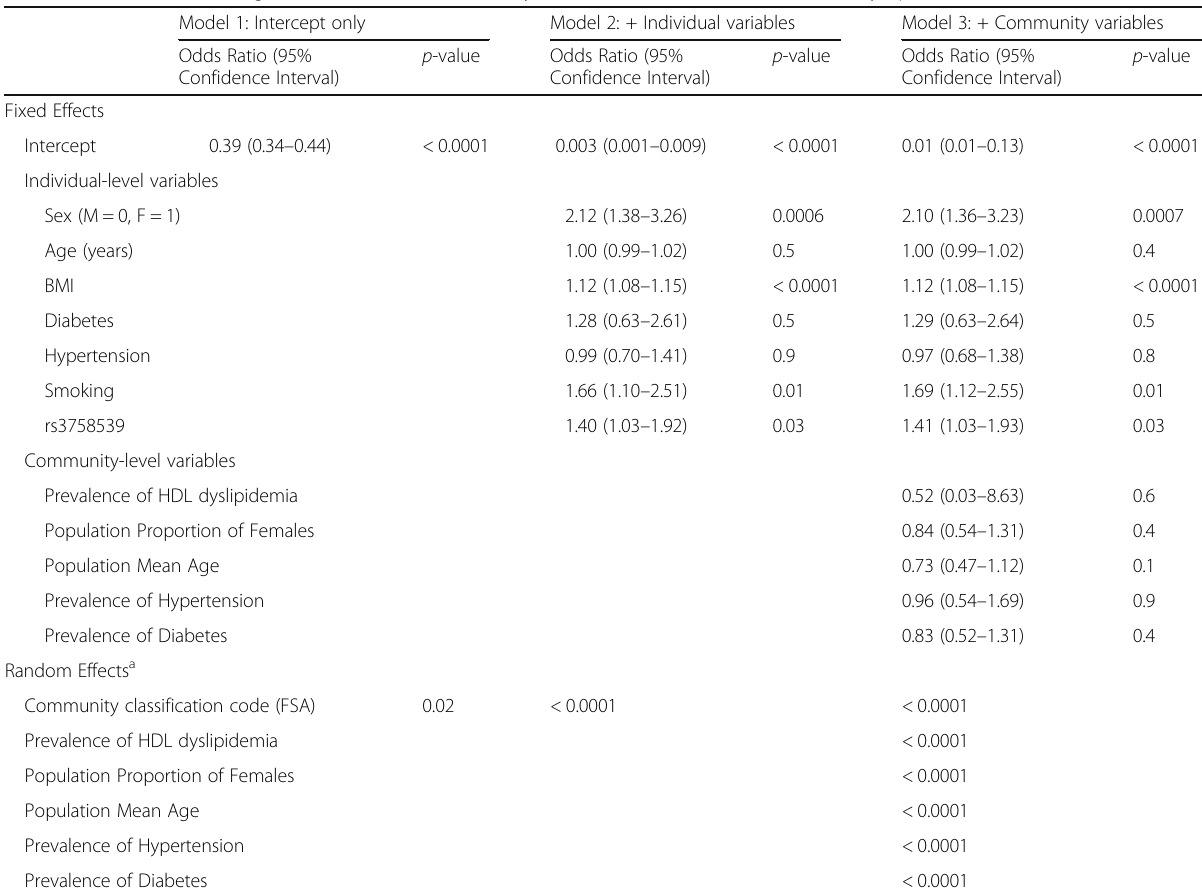
Table 4 Multilevel modeling of individual and community risk factor associations with HDL-C dyslipidemia Model 1: Intercept